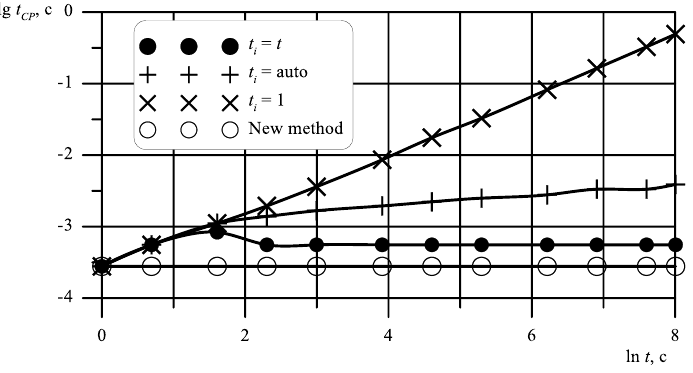
Fig. 6. CPU time for different steps of integration and using the new method